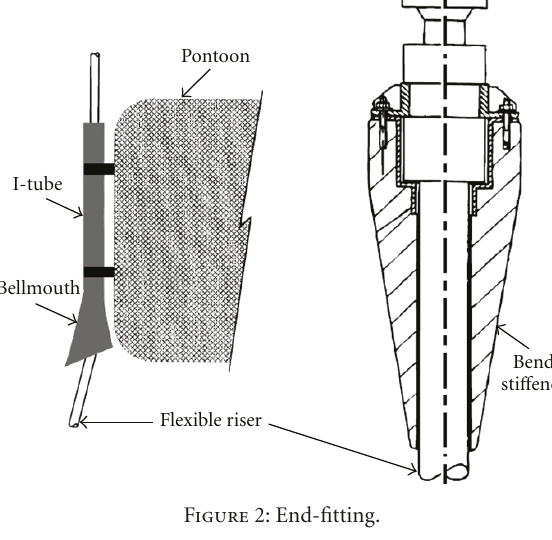
Figure 2: End-fitting.